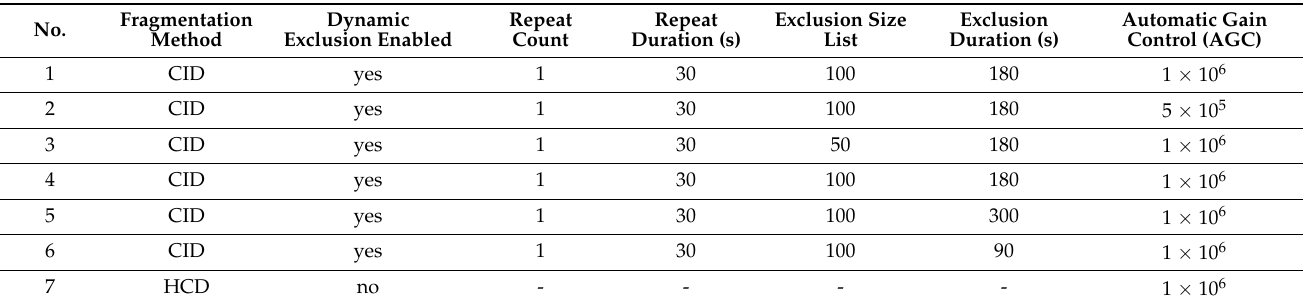
Table 3. List of MS parameters used for the identification of N-glycosylation